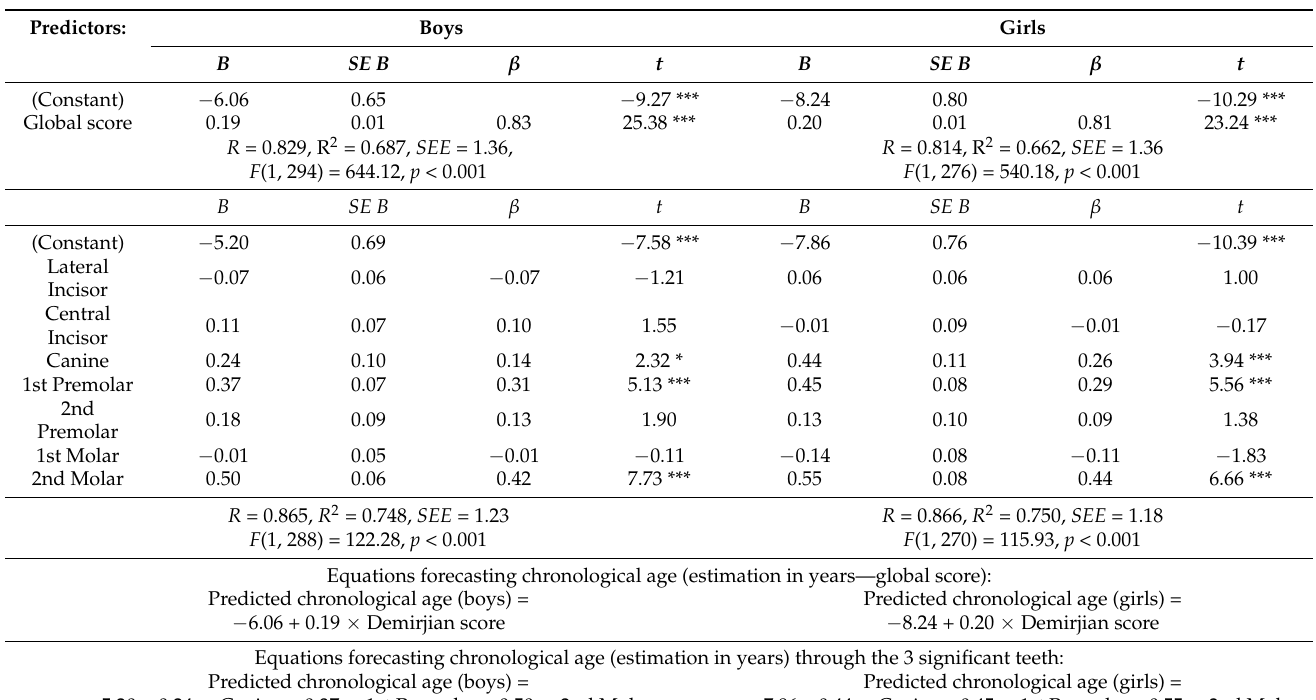
Table 3. Simple regression analysis of chronological age predicted by the Demirjian global score and tooth by tooth for boys ( n = 296) girls and girls ( n =